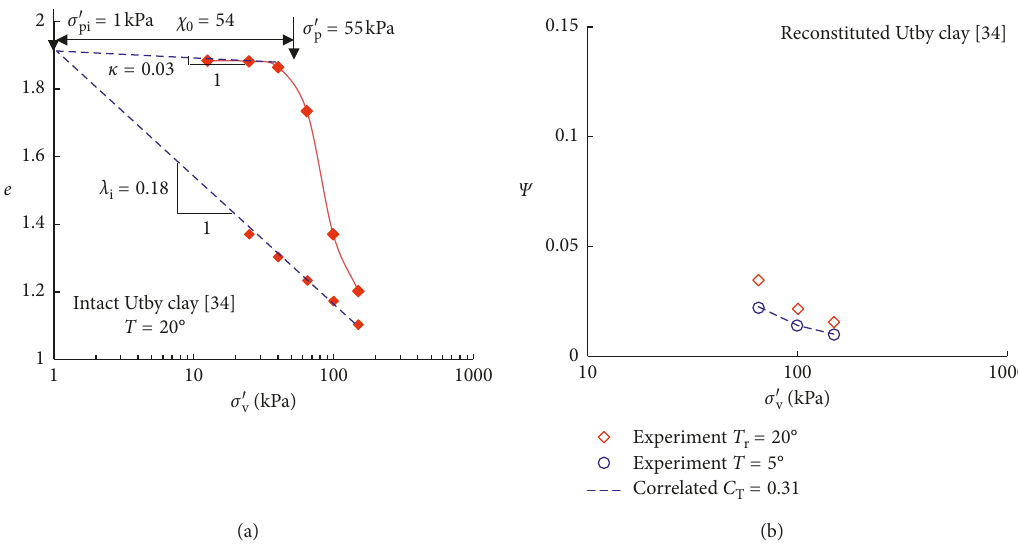
Figure 8: Determination of parameters from the thermal oedometer test: (a) compression parameters at T coefficient based on the experiment on the reconstituted sample.